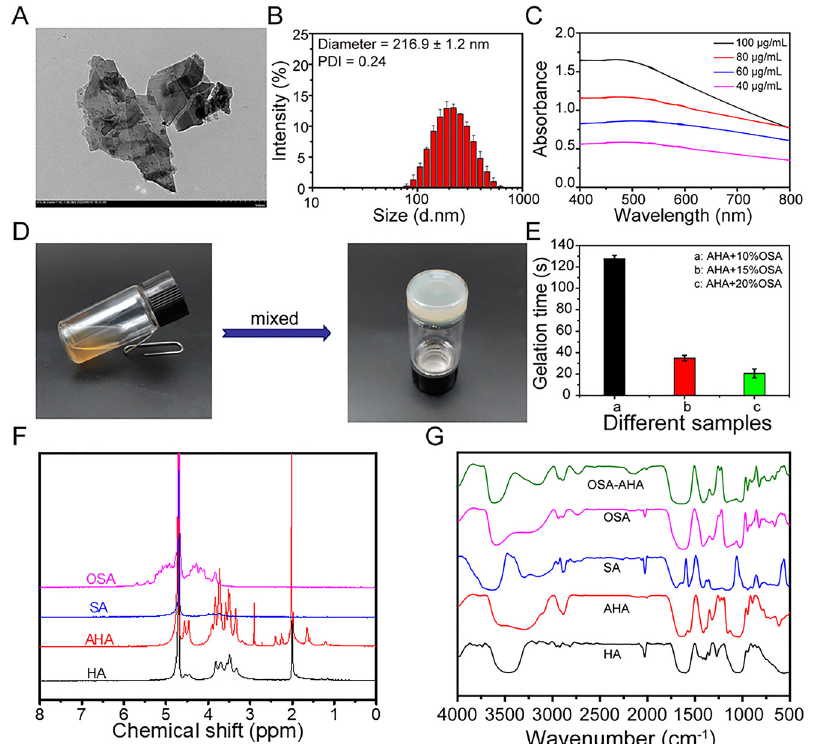
tested by dynamic light scattering (DLS), and the average particle size was 216.9 ± 1.2 nm (PDI 0.24), as shown in Figure 1B. The optical properties of BP nanosheets dispersed in aqueous solution were measured. As shown in Figure 1C, BP nanosheets have a typical broad absorption band spanning the ultraviolet and near-infrared region, which are similar to other two-dimensional layered materials.